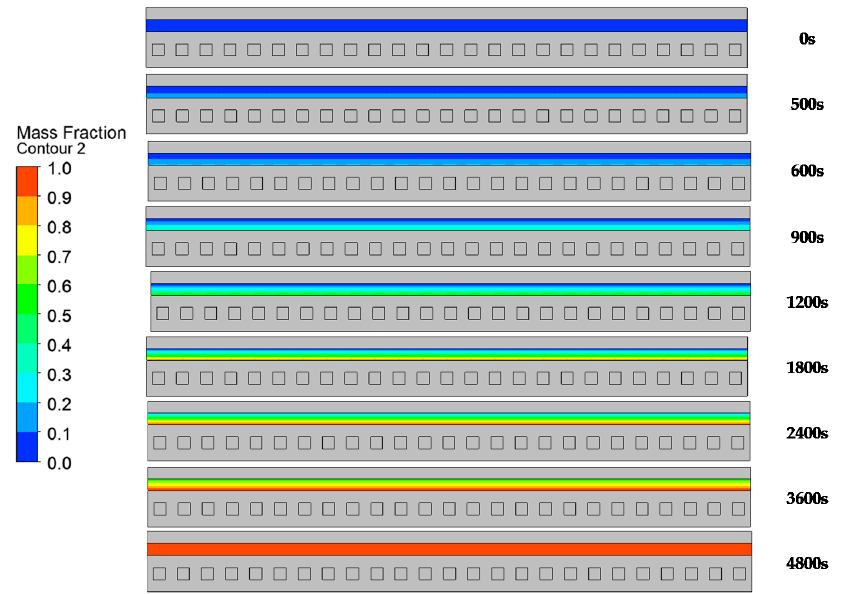
Figure 7. A section through the PCMHPHS during the heating phase, displaying the PCM liquid fraction over time.